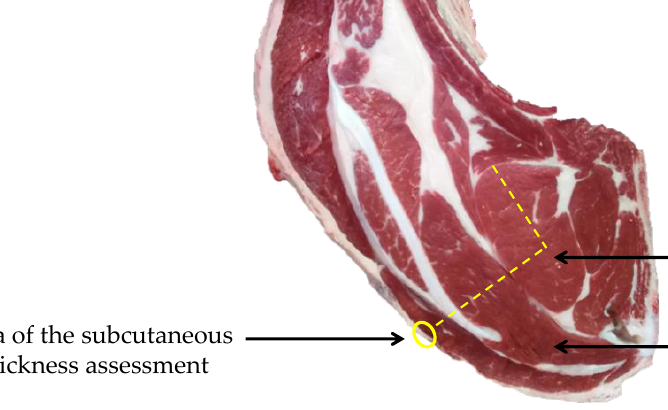
analysis because it is a specific muscle in the ribs of the chuck sale